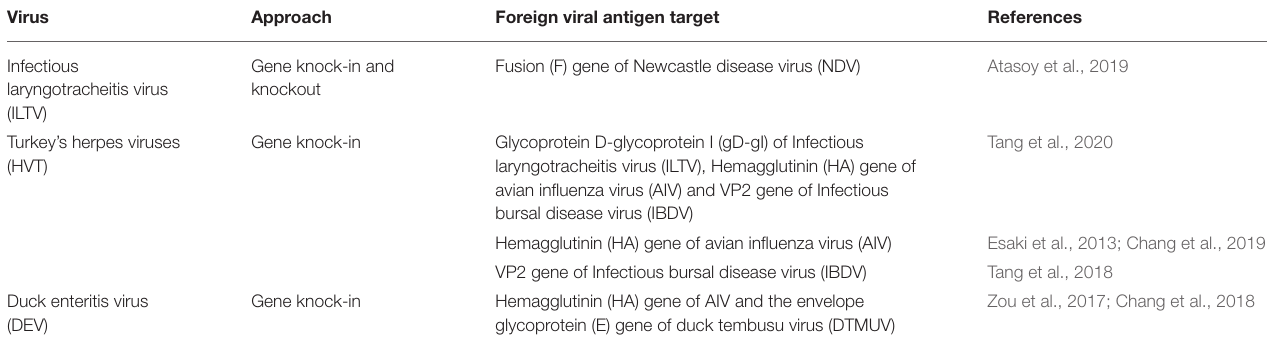
TABLE 2 | Overview of CRISPR/Cas9 applications in avian viral vaccines